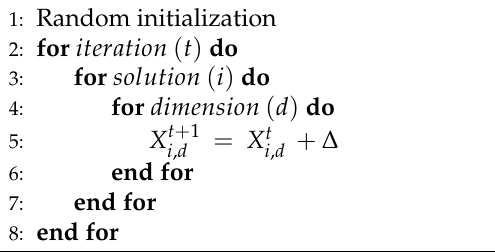
Figure 2. Nature-inspired metaheuristics.